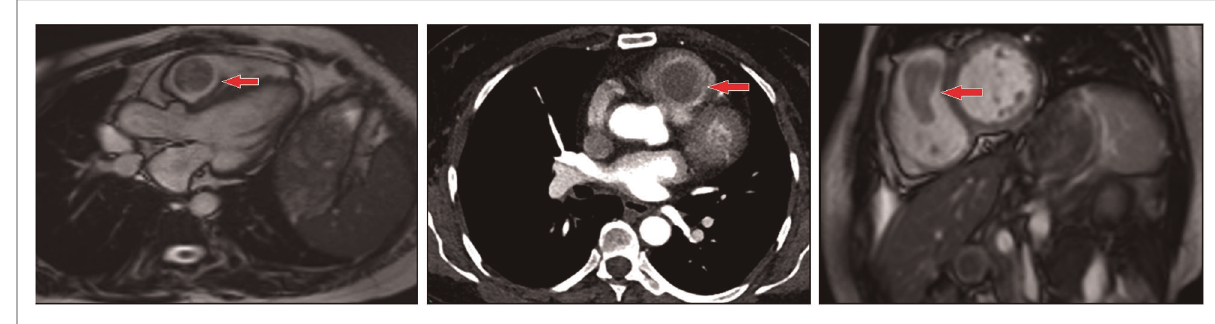
FIGURE 1 Imaging of metastasizing leiomyoma. Enhanced MRI revealed soft tissue signal mass shadows in the out fl ow tract of the right